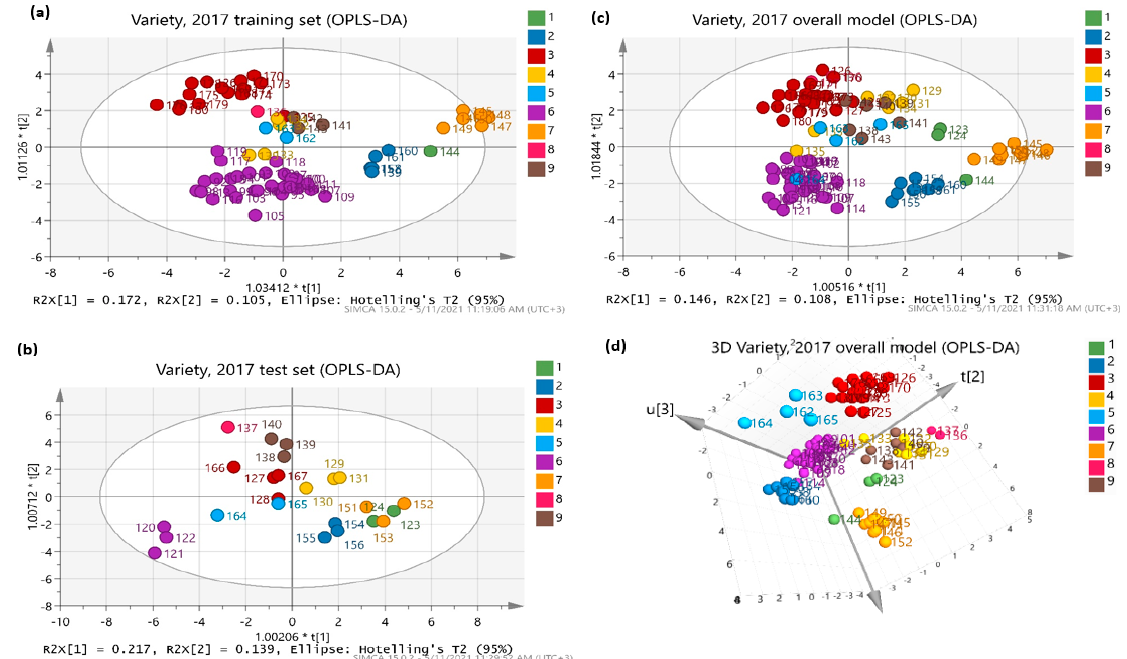
Figure 5. Score scatterplots for the wine samples of 2017 classified regarding variety (i.e., 1: Syrah, 2: Agiorgitiko, 3: Asyrtiko, 4: Malagouzia, 5: Muscat, 6: Moschofilero, 7: Xinomavro, 8: Rodoti, and 9: Savatiano), where ( a ) training set, ( b ) test set, ( c ) overall model 2D, and ( d ) overall model (3D). Table 6. Misclassification tables produced for the OPLS-DA models of the wine samples of 2018